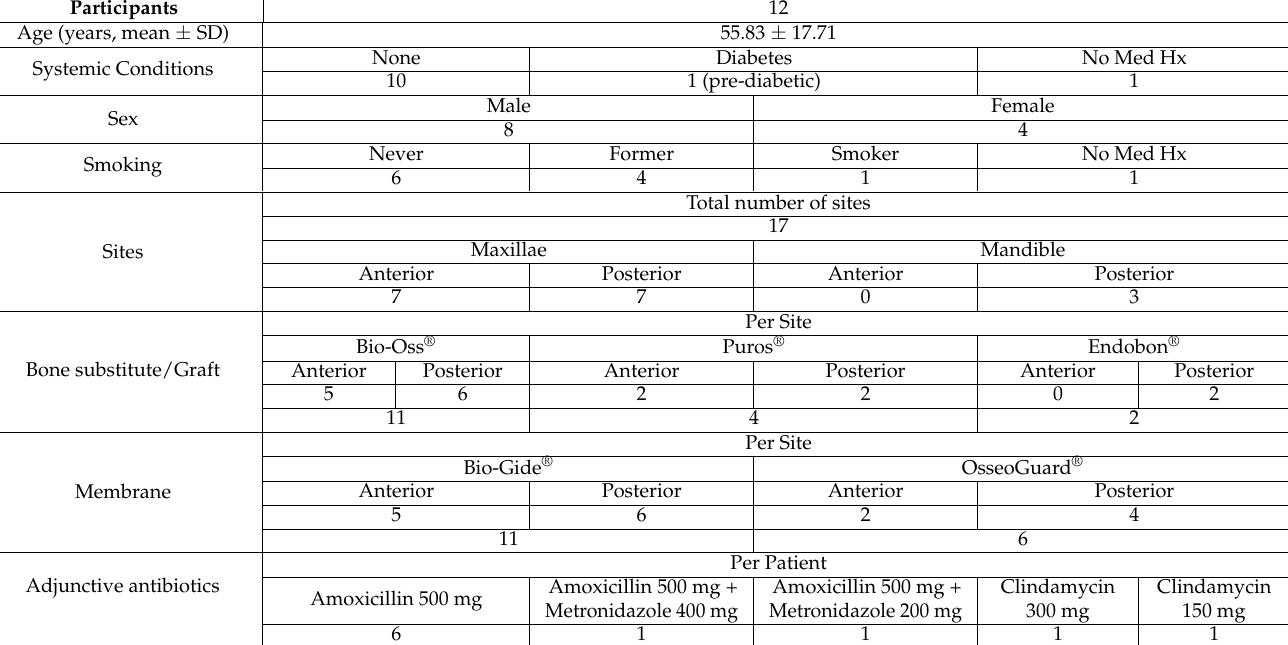
Table 1. Table outlining participant demographic and clinical information.